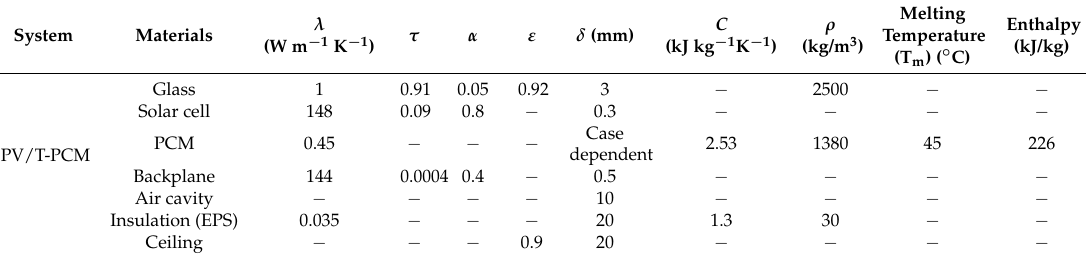
Table 2. Thermo-physical properties of the PV/T-PCM system